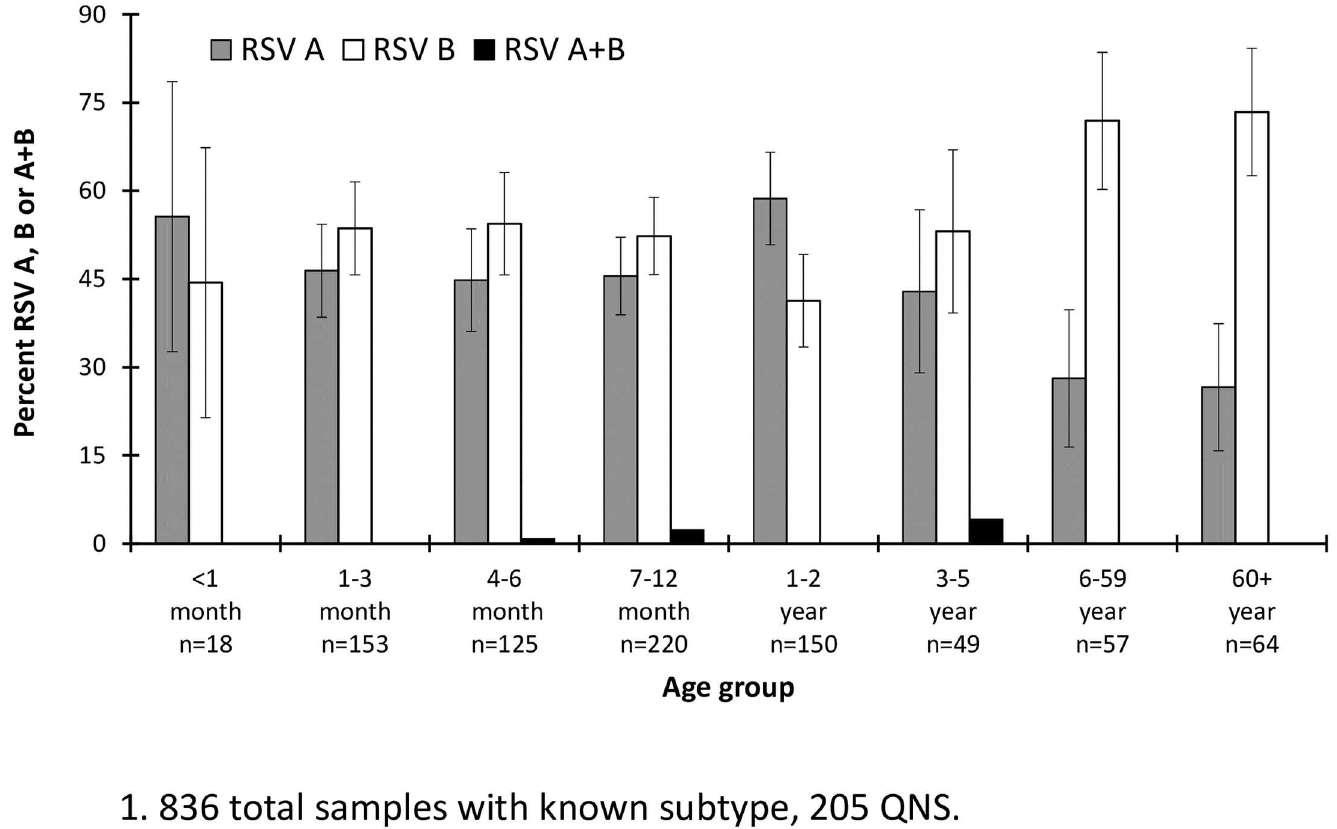
Fig 4. OUTSMART 2016–17 percent RSV-positive tests by age and subtype. Error bars represent 95% confidence intervals.